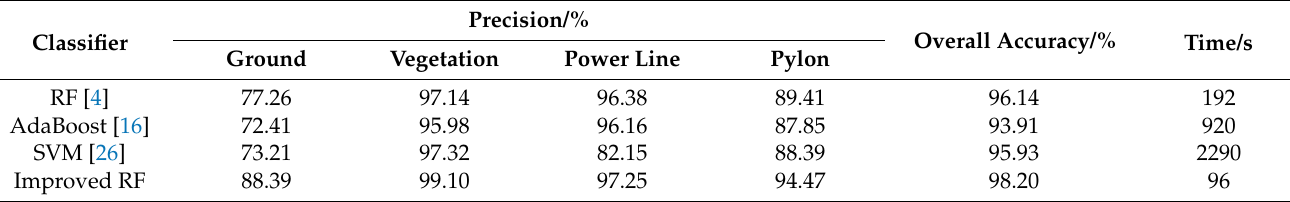
Table 5. Comparative analysis of different classification